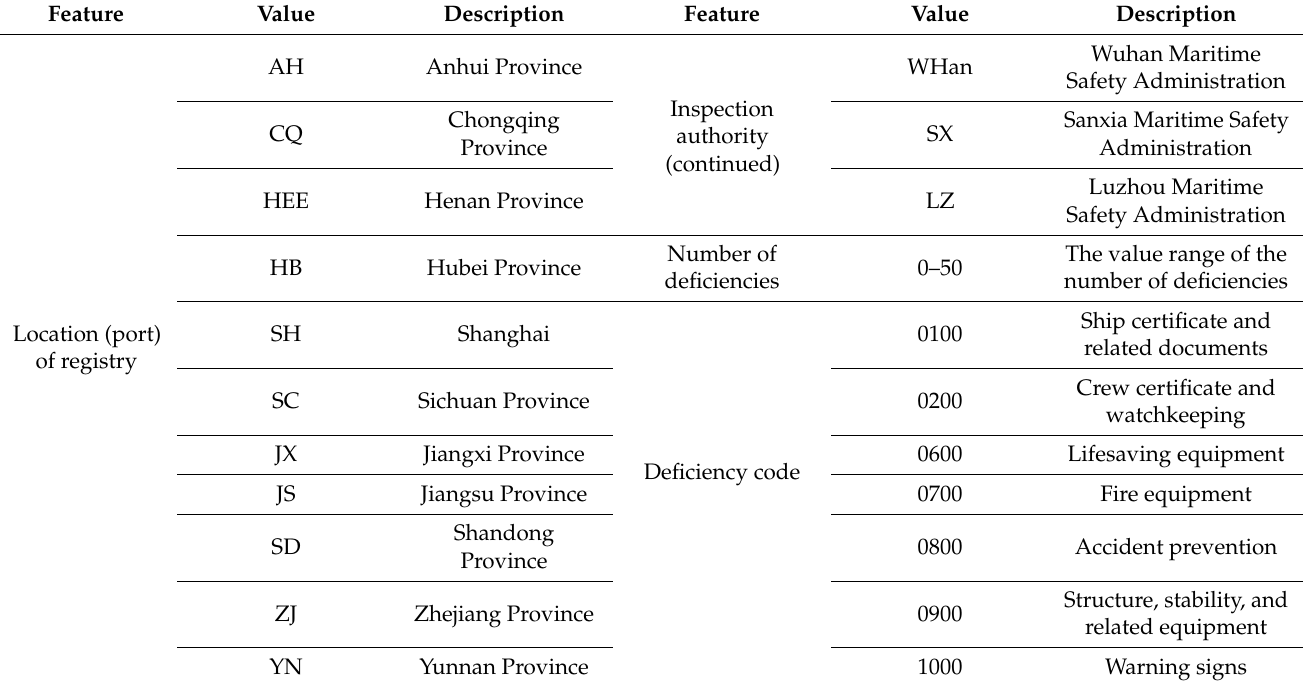
Table 2. Descriptions of the selected five